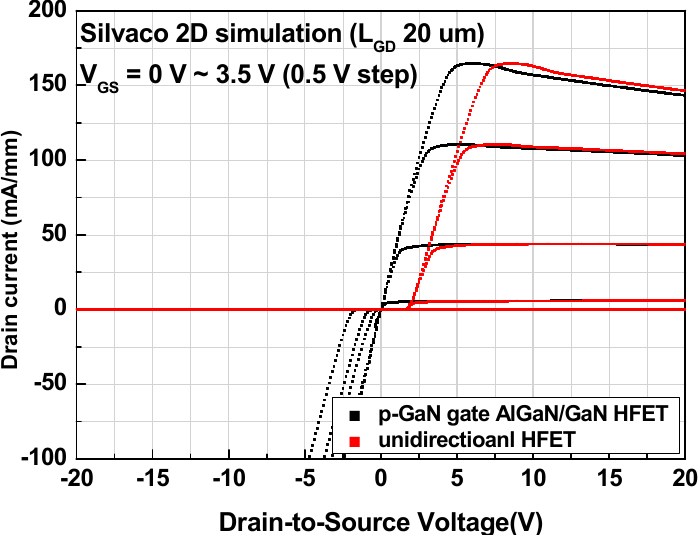
Figure 3. Forward and reverse characteristics of p-GaN gate AlGaN/GaN HFET (black lines) and unidirectional HFET (red lines).